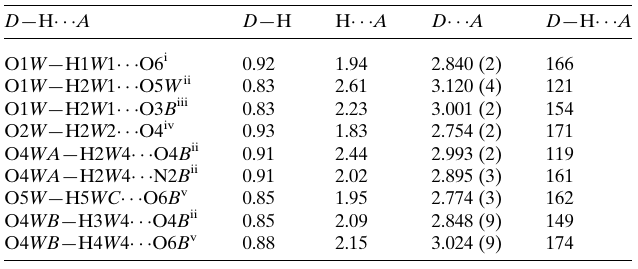
Table 3 Hydrogen-bond geometry (A˚ , (cid:4)